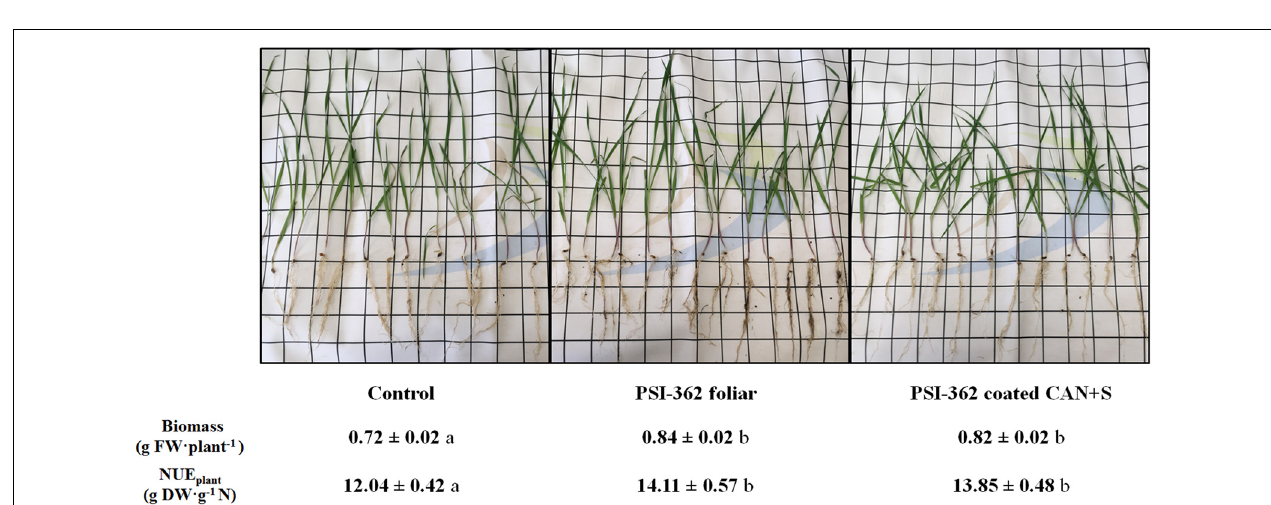
FIGURE 2 | Effect of PSI-362 treatment applied by foliar spray or coated with CAN + S fertilizer on plant biomass and NUE of winter barley (cv. Towers). A pot trial was performed to evaluate if the application mode of PSI-362 (foliar spray or coated with N mineral fertilizer) affected differently to barley growth and compared with an untreated control. Fertilizer (CAN + S) and PSI-362 biostimulant were added to plants at 2–3 leaf stage (GS12–13) at the same time. The dose of PSI-362 applied by foliar spray or coating was exactly the same and control plants were sprayed with distilled water. The phenotypical assessment was performed 14 days after fertilizer/PSI-362 treatment application. Means followed by different small letter within the same row indicate significant differences between treatments based on one-way ANOVA Tukey’s HSD test at p ≤ 0.05. Number of biological replicates (plant biomass, n = 60; NUE, n = 3).